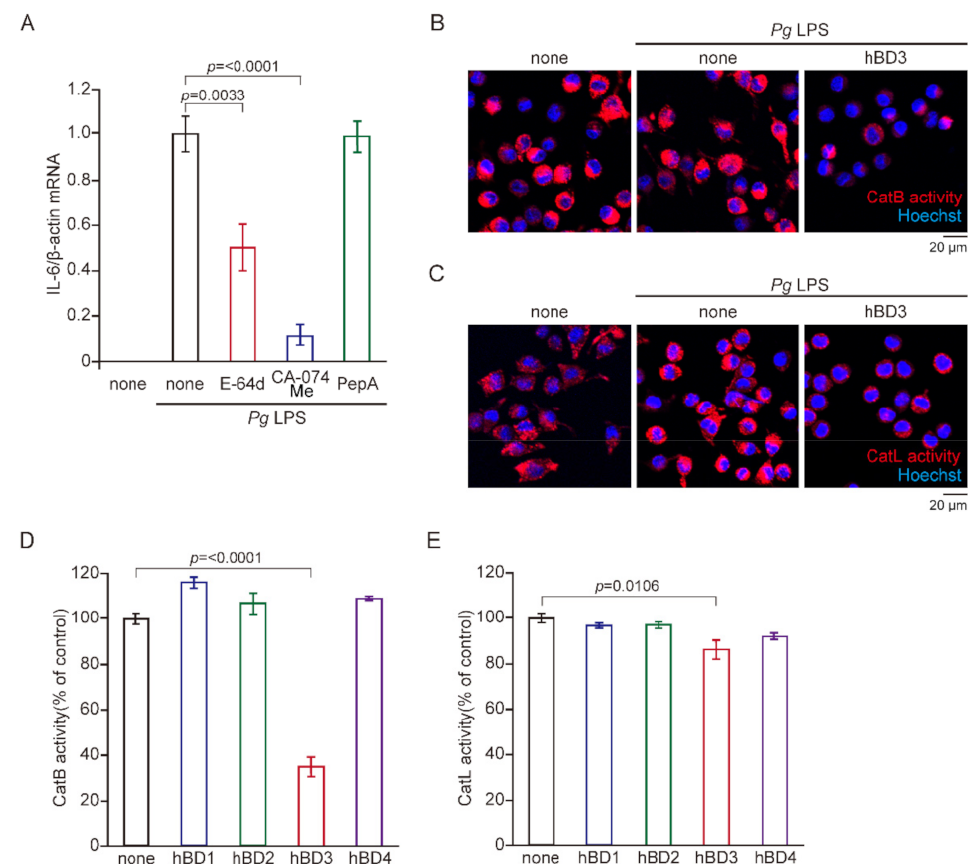
Figure 4. Effects of hBD3 on the enzymatic activity of human CatB and CatL. ( A ) The mean level of Pg LPS-induced IL-6 mRNA was significantly reduced by E64d (50 µ M) and CA-074Me (30 µ M), but not by pepstatin A (30 µ M). ( B , C ) CLSM images of z-Arg-Arg-cresyl violet ( B ) and z-Phe-Arg-cresyl violet ( C ) in non-treated and Pg LPS-treated MG6 cells in the absence and presence of hBD3 (1 µ M). ( D , E ) The mean enzymatic activity levels of human CatB ( D ) and human CatL ( E ) were measured by measured by AFC based peptide substrates to release AFC. ( A , D , E ) The data are presented as the mean ± SE of three independent experiments, and p values were calculated using a one-way ANOVA with a post-hoc Tukey’s test. A value of p < 0.05 was considered to indicate statistical